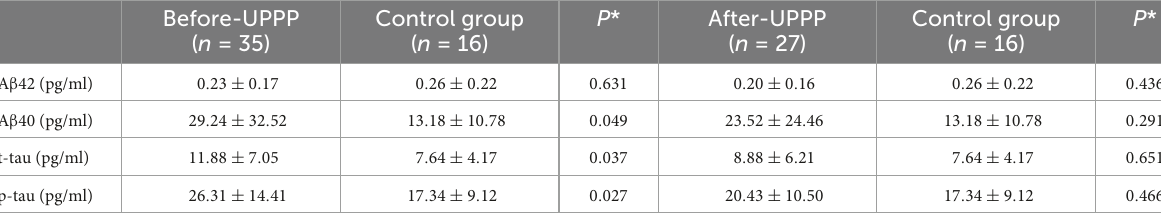
TABLE 3 Differences of Alzheimer’s disease (AD) biomarkers in three groups.